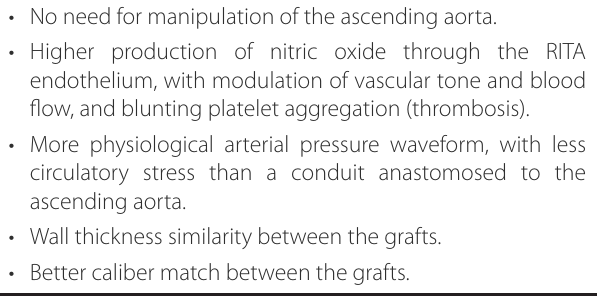
Table 1 . Advantages of anastomosing the vein graft to the RITA proximal